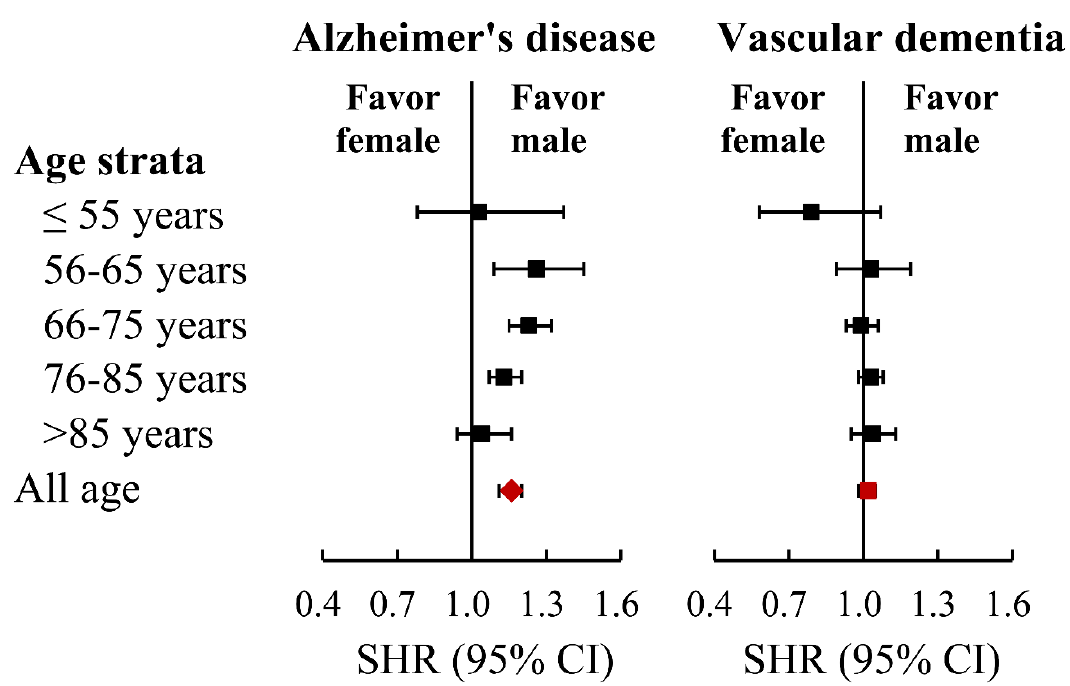
Figure 6. Forest plots for demonstrating the sex differences in the risk of Alzheimer’s disease and vascular dementia across different age groups in the propensity score matched cohort.